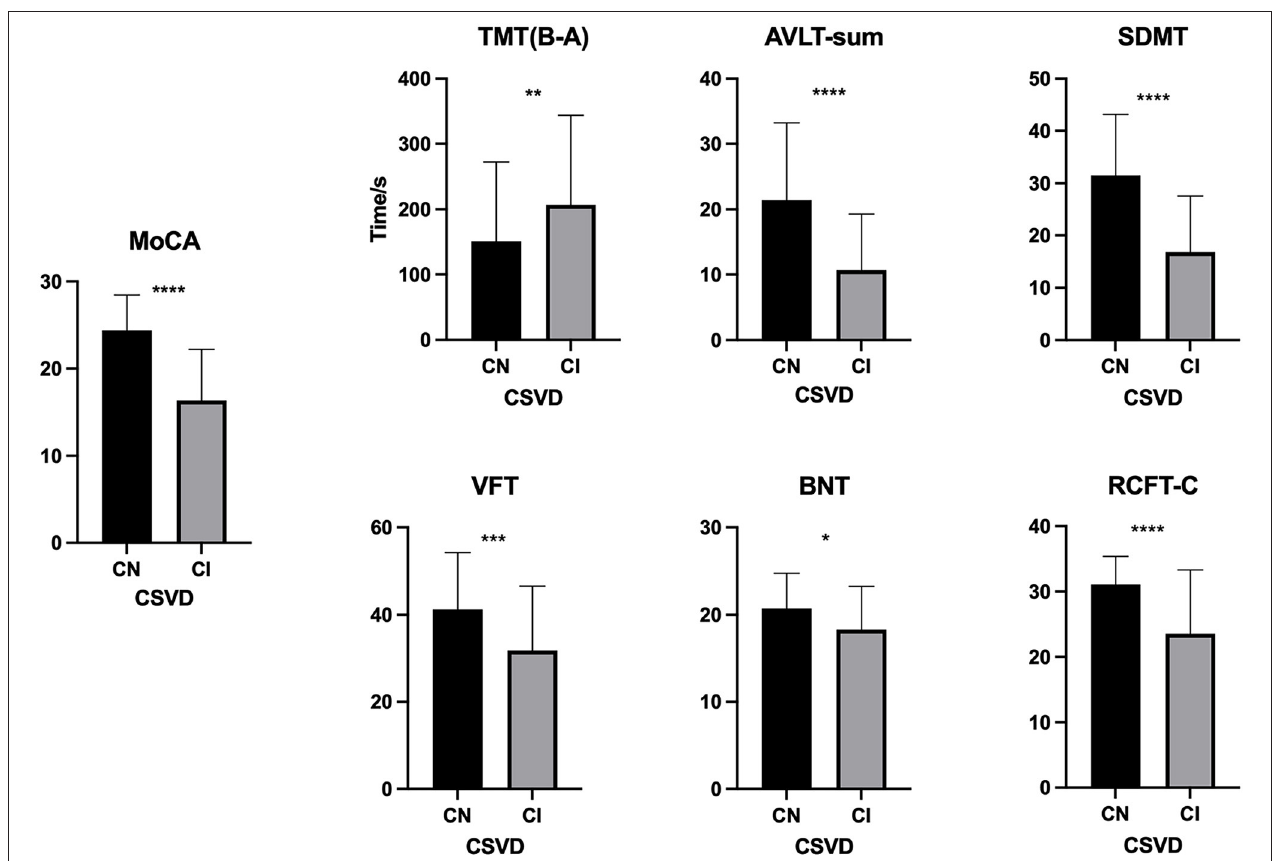
FIGURE 1 | Comparison of neuropsychological test results between the cognitive normal (CN) and cognitive impairment (CI) groups. The difference between the CN and CI groups in the Montreal Cognitive Assessment (MoCA), the Trail Making Test B and A time [TMT (B-A)], the Auditory Verbal Learning Test (AVLT)-sum, the Symbol Digit Modalities Test (SDMT), the Verbal Fluency Test (VFT), the Boston Naming Test (BNT), and the Rey’s Complex Figure Test (RCFT-C). * p < 0.05, ** p ≤ 0.01, *** p ≤ 0.001, and **** p ≤ 0.0001.